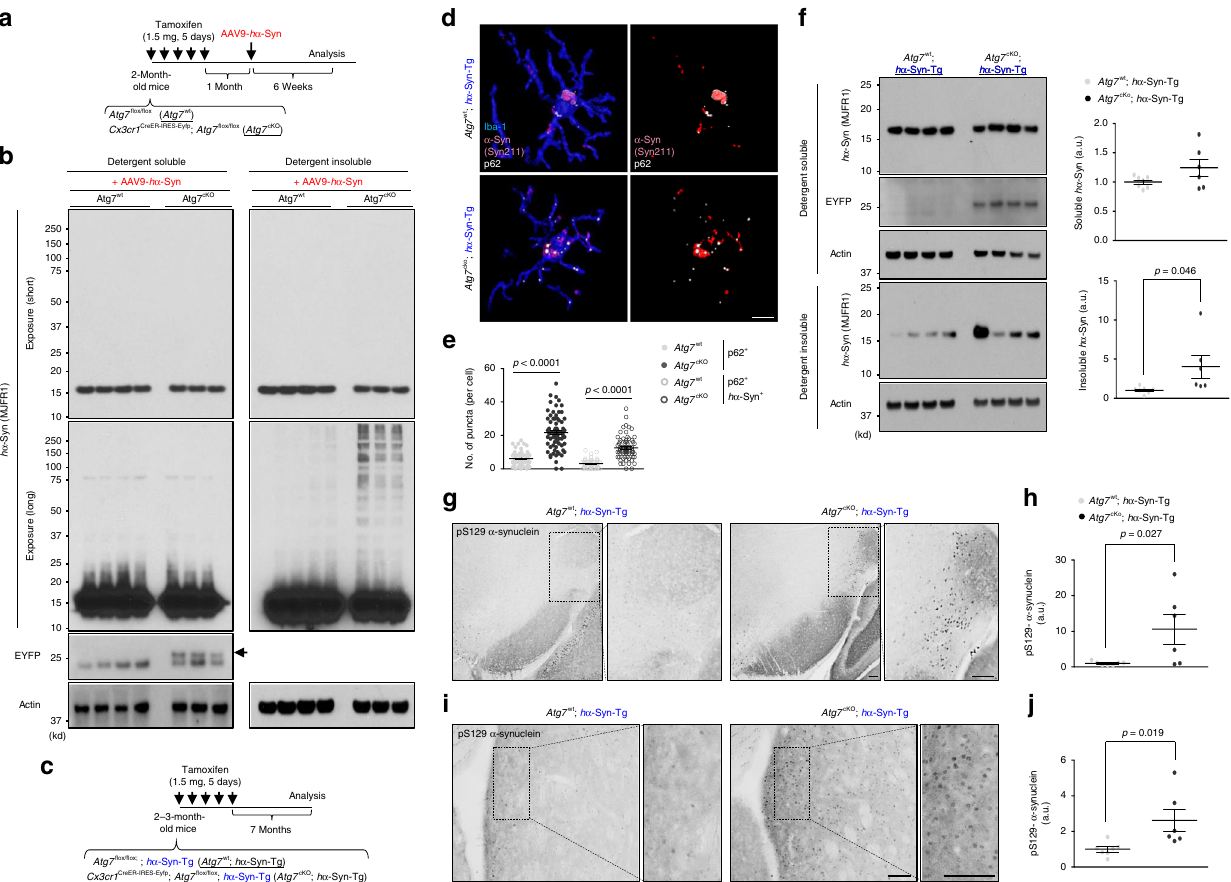
Fig. 6 Autophagy-de fi cient microglia cause α -synuclein accumulation. a Experimental plan to test the roles of microglia-speci fi c Atg7 -de fi ciency in AAV- h α -Syn mice. b After 6 weeks after AAV- h α -Syn, brains from Atg7 fl ox/ fl ox mice ( n = 4) and Cx3cr1 CreER-IRES-Eyfp ; Atg7 fl ox/ fl ox mice ( n = 3) were homogenized and fractionated into a detergent-soluble fraction and detergent-insoluble fraction and assayed for W.B using antibodies against human α - synuclein, and GFP/YFP. Actin were used as loading controls. Arrow indicates the EYFP band. c Experimental plan to test the roles of microglia-speci fi c Atg7 -de fi ciency in h α -Syn-Tg mice. d , e At 7 months after tamoxifen treatment, brain slices were fi xed and stained with antibodies against human α - synuclein, p62, and Iba-1. Representative 3D reconstruction pictures of microglia containing p62 and human α -synuclein in the striatum of Atg7 fl ox/ fl ox mice and Cx3cr1 CreER-IRES-Eyfp ; Atg7 fl ox/ fl ox mice bred with h α -Syn-Tg mice were produced using Imaris (Bitplane, d ). The number of p62 puncta or p62-positive/ h α -Syn-positive puncta was quanti fi ed in microglia at striatum of Atg7 fl ox/ fl ox ; h α -Syn-Tg mice ( n = 5) and Cx3cr1 CreER-IRES-Eyfp ; Atg7 fl ox/ fl ox ; h α -Syn-Tg mice ( n = 5) ( e ). p -values were calculated by two-tailed Mann – Whitney U test. Scale bar, 10 µ m. f At 7 months after tamoxifen treatment, brains from Atg7 fl ox/ fl ox ; h α -Syn-Tg mice ( n = 7) and Cx3cr1 CreER-IRES-Eyfp ; Atg7 f lox/ fl ox ; h α -Syn-Tg mice ( n = 6) were homogenized and fractionated into detergent- soluble fraction and detergent-insoluble fraction, and assayed for W.B using antibodies against human α -synuclein, and GFP/YFP for con fi rming the presence of Cx3cr1 CreER-IRES-Eyfp . Band intensities were quanti fi ed in the lower panel. p -values were calculated by unpaired two-tailed Student ’ s t test. g – j p- S129- α -synuclein-positive structures were visualized in brain sections from A tg7 fl ox/ fl ox ; h α -Syn-Tg mice ( n = 7) and Cx3cr1 CreER-IRES-Eyfp ; Atg7 fl ox/ fl ox ; h α - Syn-Tg mice ( n = 6) through DAB staining method ( g , i ), and quanti fi ed ( h , j ). p -values were calculated by unpaired two-tailed Student ’ s t test. Scale bar, 100 µ m. All values are reported as mean ± SEM. Data are representative of at least three independent